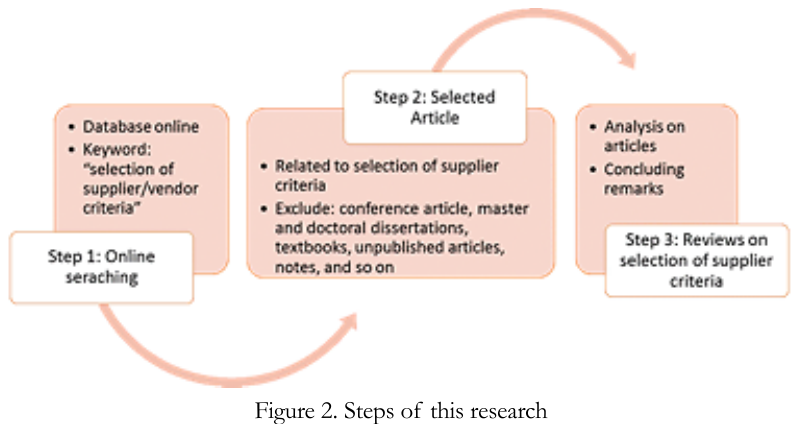
Figure 2. Steps of this research